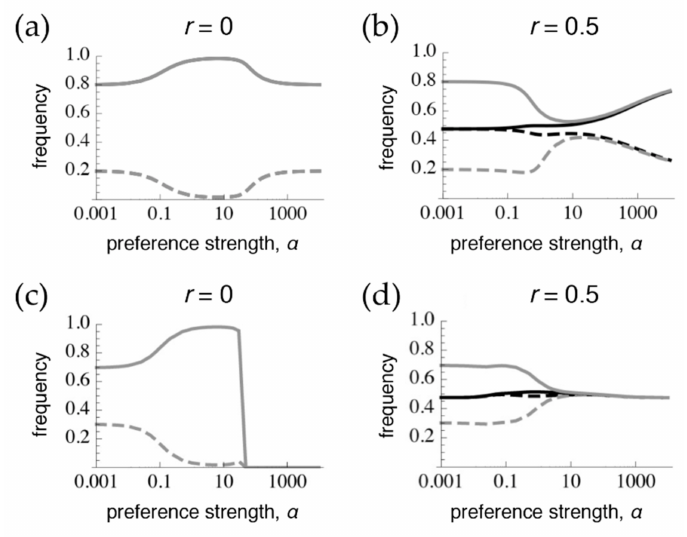
Figure 1. Preference and trait frequencies 1 million generations after secondary contact via the onset of migration. Starting conditions are population 1: p 1 = t 1 = 1.0, population 2: p 2 = t 2 = 0.95 with full linkage disequilibrium. Grey: frequency of the trait T 2 , black: frequency of the preference P 2 , solid: frequencies in population 2, dashed: frequencies in population 1. The difference between the solid and dashed lines for the trait (preference) can be thought of as the amount of trait (preference) divergence. Lines are extrapolations between discrete data points obtained by numerical simulations. The symmetrical migration rate m = 0.01 and the strength of selection for local adaptation in both populations s = 0.038. The trait is expressed in both sexes in the top row in ( a , b ), and is expressed only in males in ( c , d ). Note that, as discussed in the main text, slightly different starting conditions will lead to slightly different curves at 1 million generations (in ( a , b ) because there is a line of equilibrium present, and in ( c , d ) because of extremely slow convergence to an equilibrium point determined by α